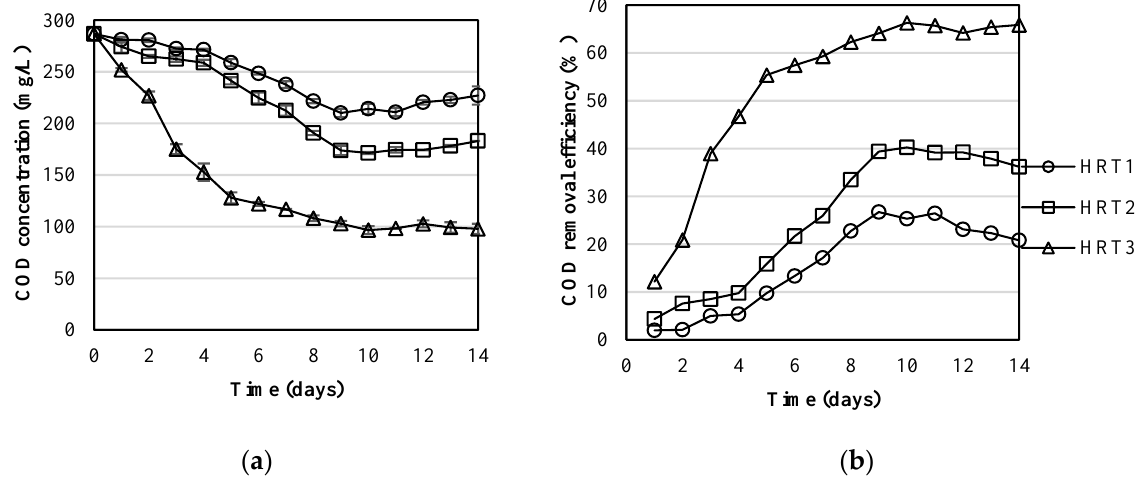
Figure 5. The change of ( a ) COD concentration and ( b ) COD removal efficiency in 2-fold diluted piggery wastewater over 14 days in Chlorella vulgaris -based MPBR at various hydraulic retention times (HRT1 = 1.25 days, HRT2 = 2.5 days, HRT 3 = 5 days).